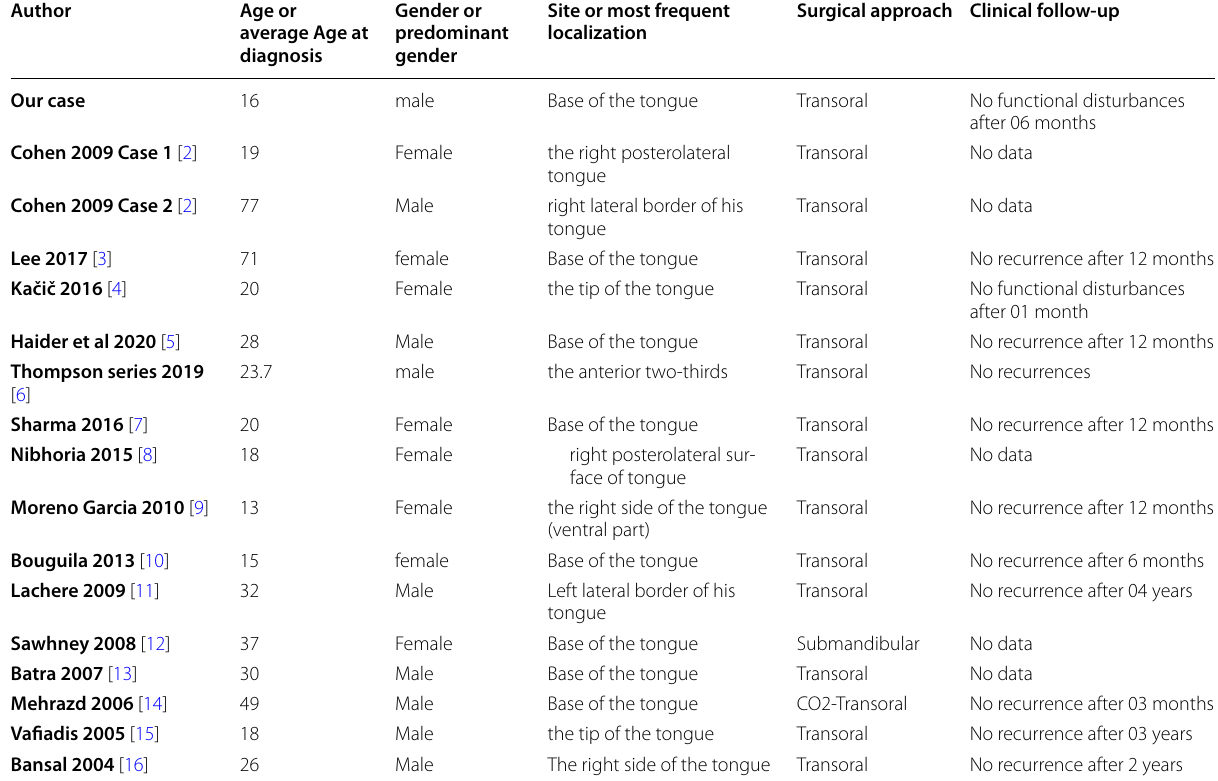
Table 1 Comparison table with previously reported cases of tongue